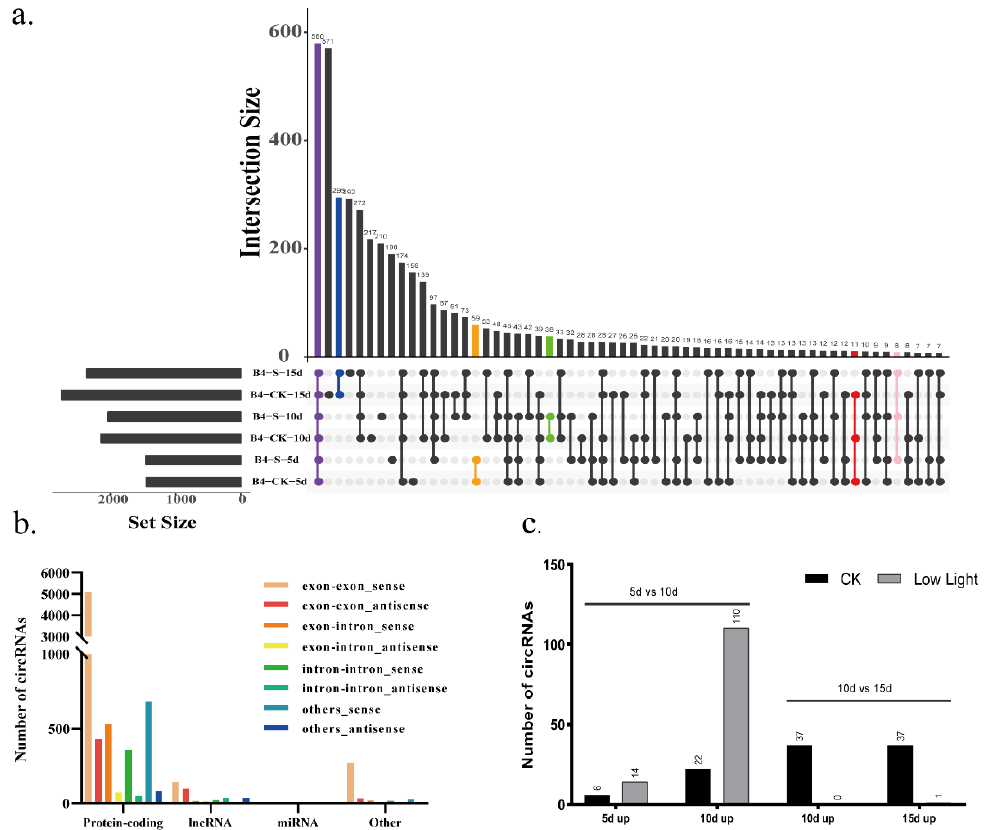
Figure 2. ( a ) The number of circRNAs shared between different light treatments or different grain- filling days: all samples (purple), the treatment and control after 5 days (orange), treatment and control after 10 days (green), 5, 10 and 15 days of control (red), and 5, 10, and 15 days of low light (pink). ( b ) The sequences of all circRNAs constitute a specific source. ( c ) The numbers of differentially expressed circRNAs were compared in the control at 5 and 10 days, and at 10 and 15 days after low light treatment. 5d up: the number of circRNAs expressed in grains after 5 days of low light was higher than that after 10 days of low light; 10d up: the number of circRNAs expressed in grains after 10 days of low light was higher than that after 5 or 15 days of low light; 15d up: the number of circRNAs expressed in grains after 15 days of low light was higher than that after 10 days of low light; CK: normal light; S-5d: low light for 5 days; S-10d: low light for 10 days; S-15d: low light for 15 days; CK-5d: normal light for 5 days; CK-10d: normal light for 10 days; CK-15d: normal light for 15 days.